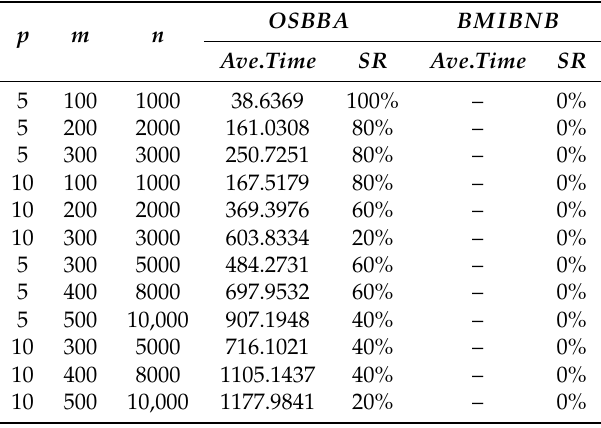
Table 5. The results of random calculations for Example